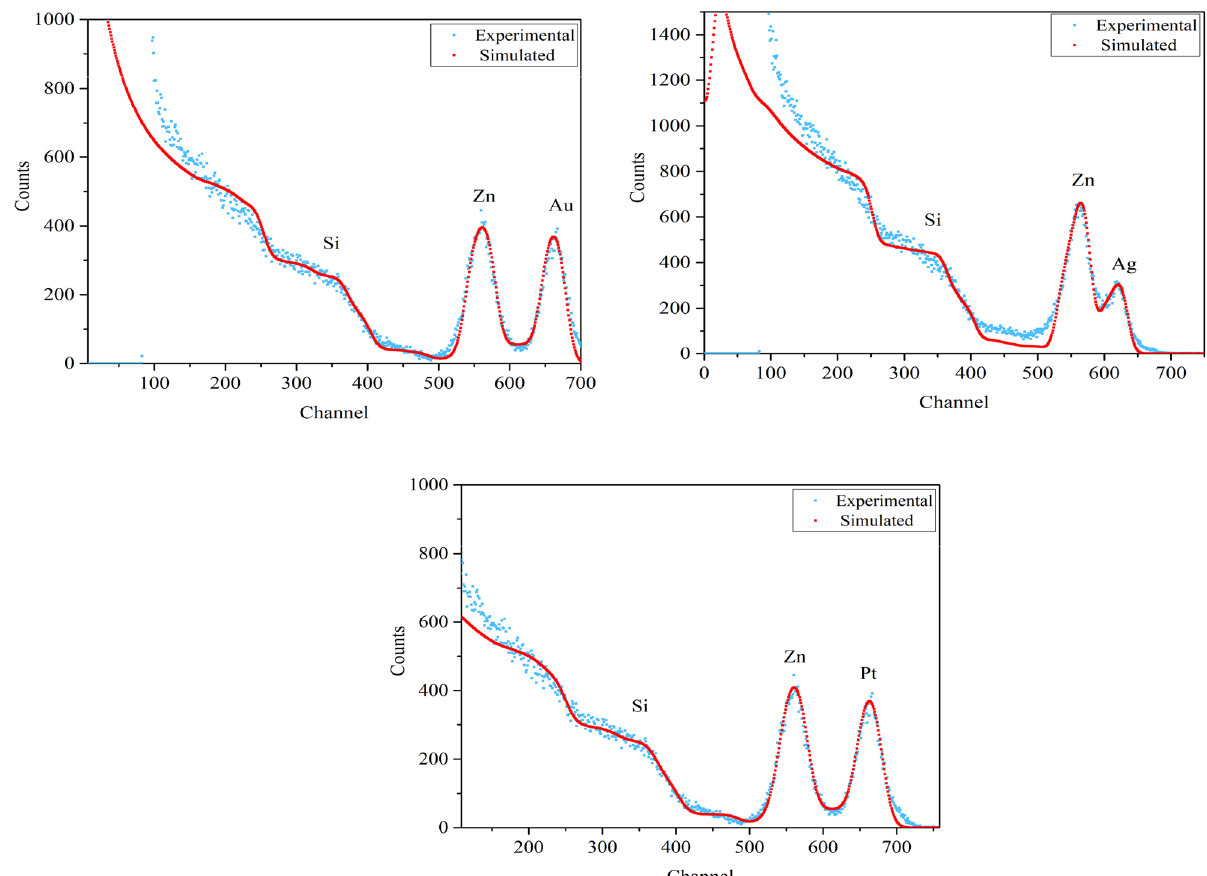
Figure 1. RBS spectra (experimental and simulation) of samples.